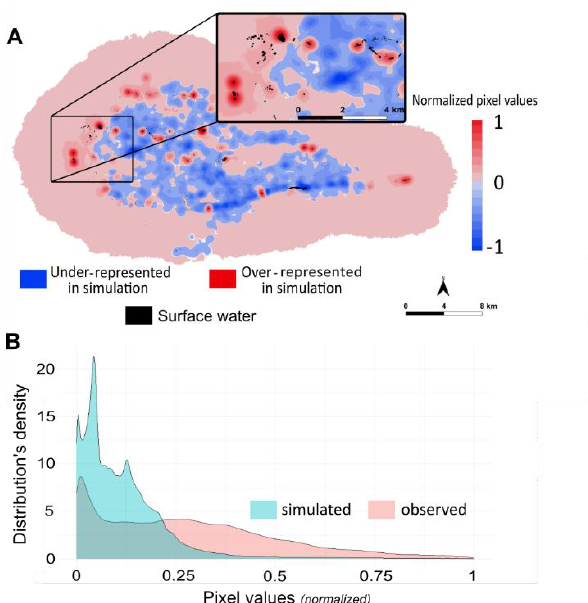
Figure 6. A) Difference of density map between observed and simulated herd’s centroids trajectories. B) Graph representing the distributions of pixel values in the simulated and observed median density rasters (c.f.